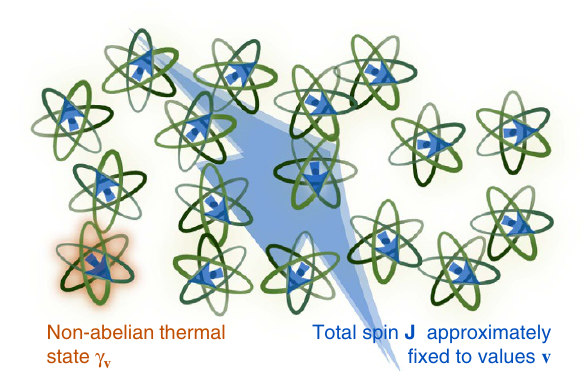
Figure 1 | Non-Abelian thermal state. We derive the form of the thermal state of a system that has charges that might not commute with each other.